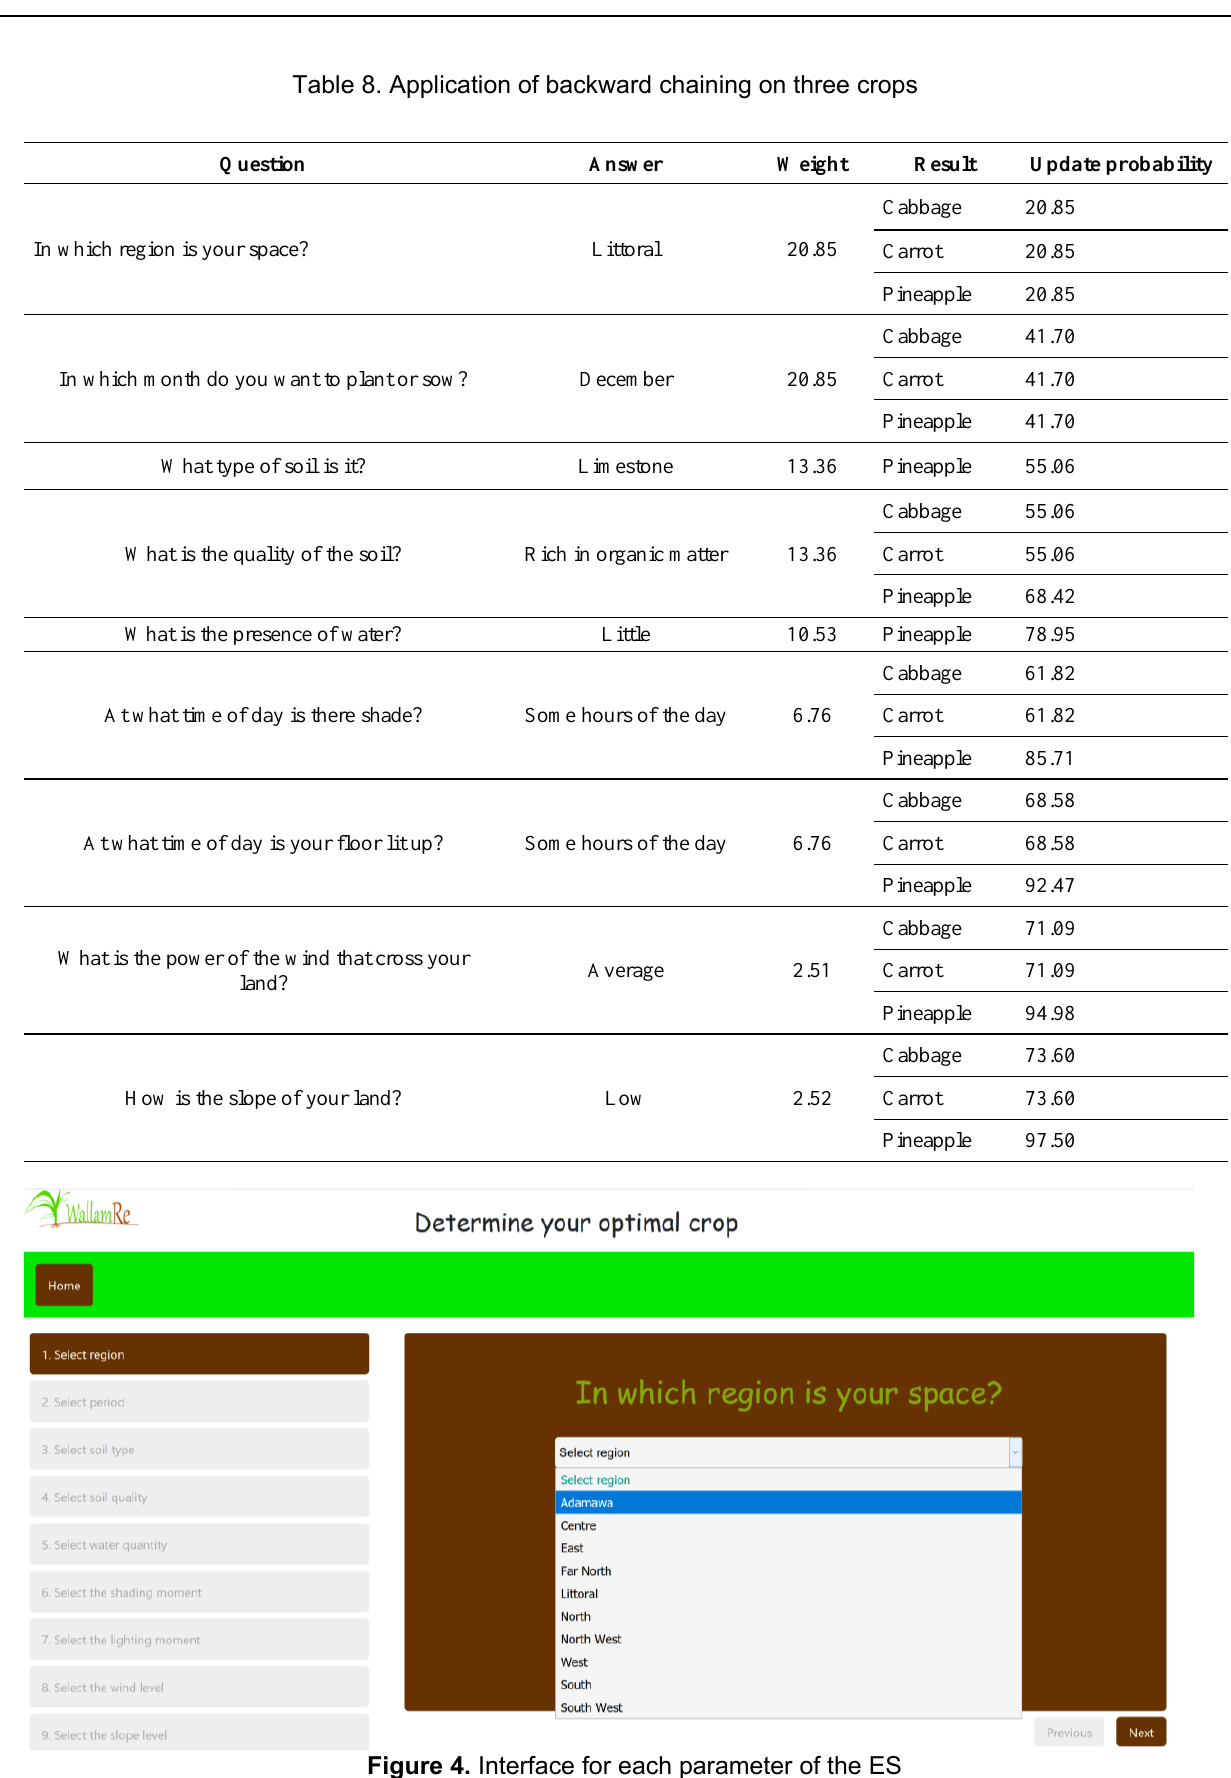
Figure 4 . Interface for each parameter of the